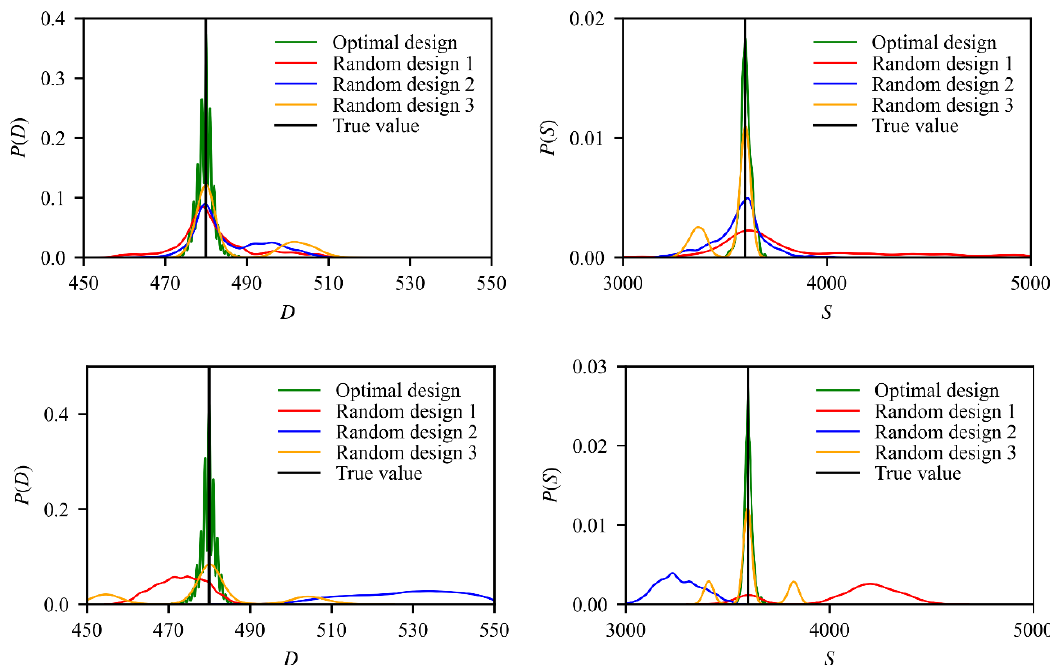
Figure 9. Comparison results of the posterior probability distributions for the optimal design and 3 other random designs for Case 1 ( Upper ) and Case 2 ( Lower ).